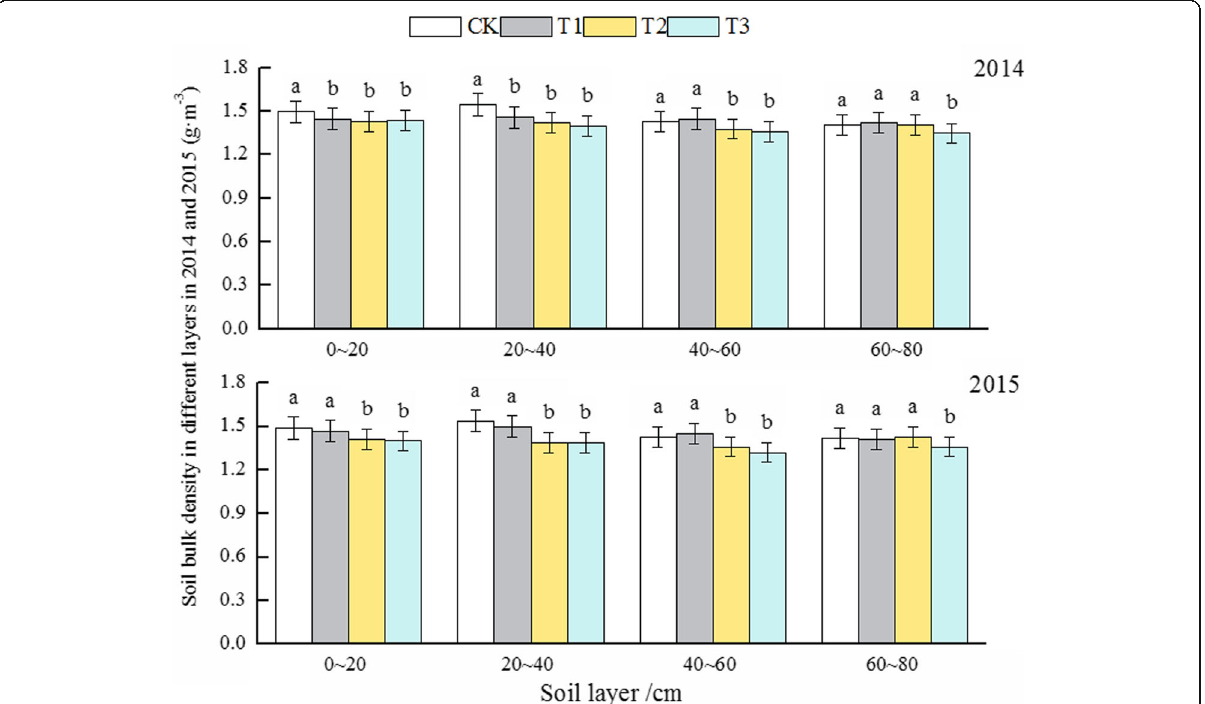
Fig. 2 Changes in soil bulk density in different layers in different